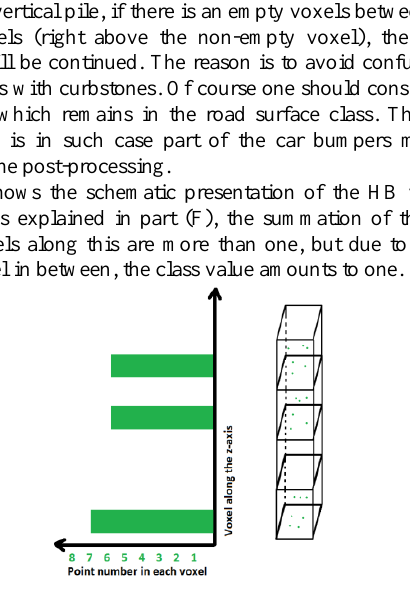
Figure 4. Schematic view of the HB